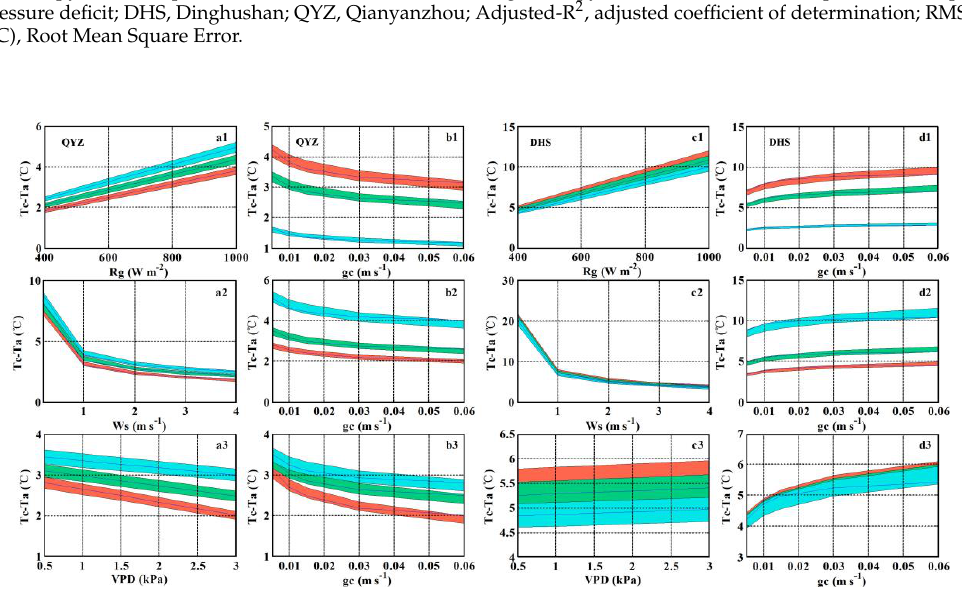
Figure 5 . Sensitivity of canopy-to-air temperature difference (ΔT) to changes in environmental factors. The red, green, and blue bands in ( a1 – a3 ) and ( c1 – c3 ) indicate the different conditions of g c at the maximum g c , 1/4 maximum g c , and 1/10 maximum g c at the QYZ and DHS sites. The red, green, and blue bands in ( b1 – b3 ) and ( d1 – d3 ) indicate the different conditions of Rg, Ws, and VPD at the QYZ and DHS sites. The red, green, and blue bands in ( b1 ) and ( d1 ) indicate the different conditions of Rg at 800 W m −2 , 600 W m −2 , and 200 W m −2 at the QYZ and DHS sites. The red, green, and blue bands in ( b2 ) and ( d2 ) indicate the different conditions of Ws at 3 m s −1 , 1.5 m s −1 , and 0.5 m s −1 at the QYZ and DHS sites. The red, green, and blue bands in ( b3 ) and ( d3 ) indicate the different conditions of VPD at 3 kpa, 1.5 kpa, and 0.5 kpa at the QYZ and DHS sites. Tc, canopy temperature; Ta, air temperature; ΔT, canopy-to-air temperature difference; Rg, solar radiation; g c , canopy conductance; Ws, wind speed; VPD, vapor pressure deficit; DHS, Dinghushan; QYZ, Qianyanzhou.